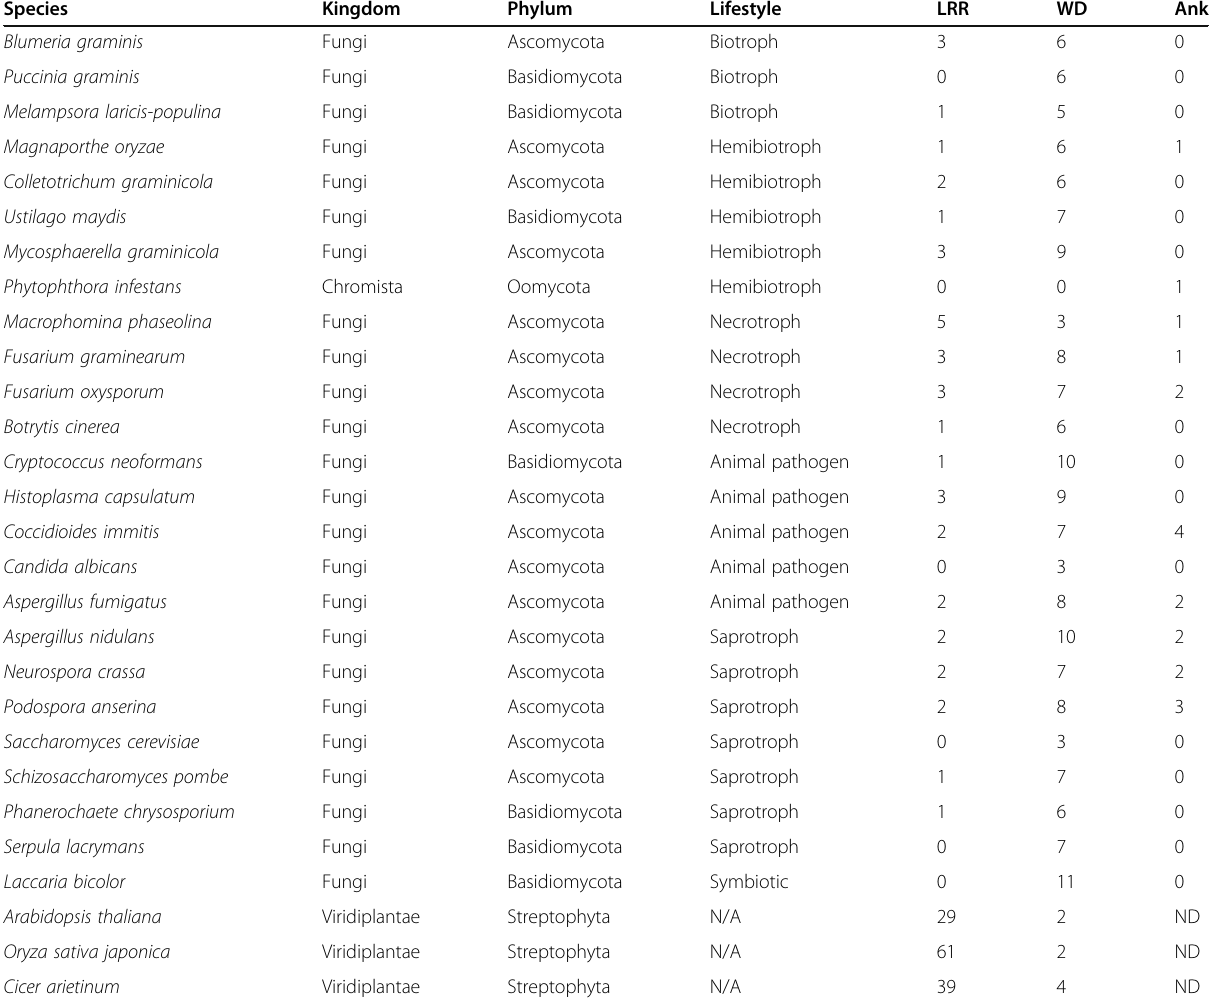
Table 3 Comparison of leucine-rich repeat (LRR), WD40 (WD), and ankyrin (Ank) repeat in